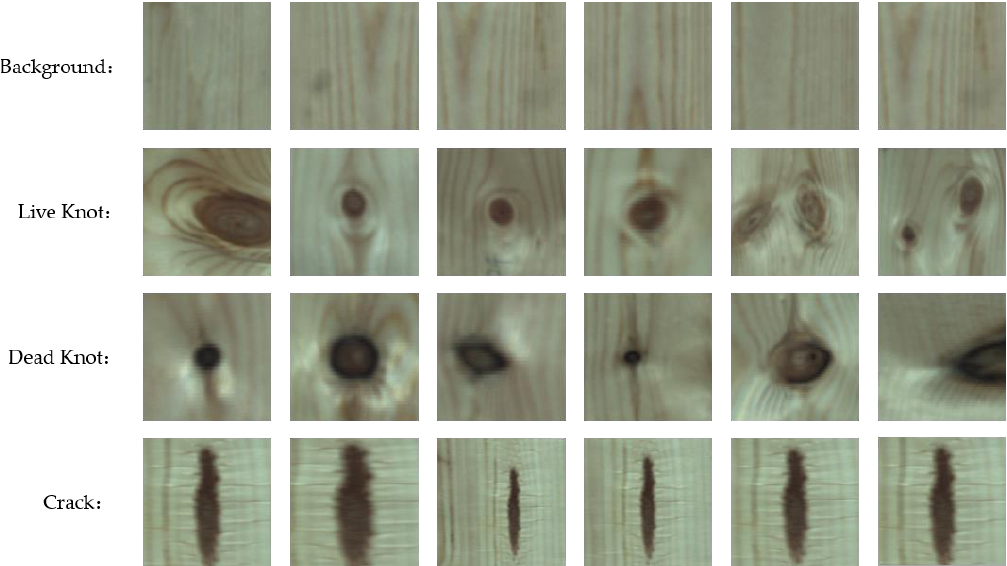
Figure 3. Regular wood pieces as background and three common wood defects taken from the dataset.